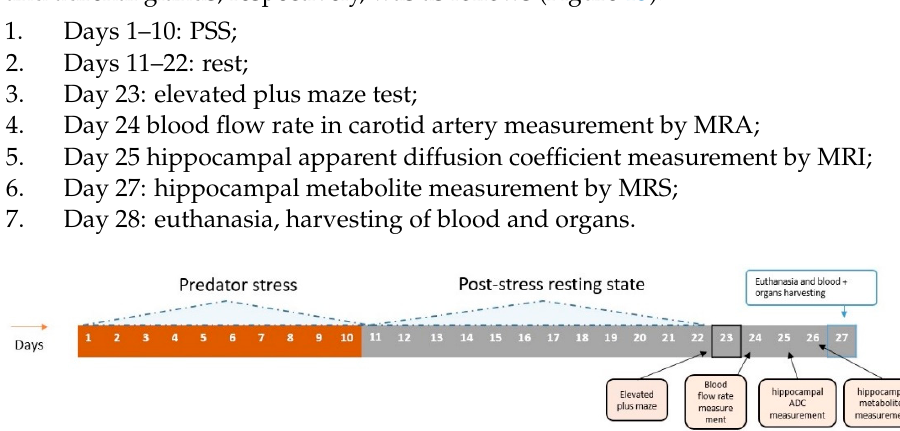
Figure 13. Graphic timeline of the